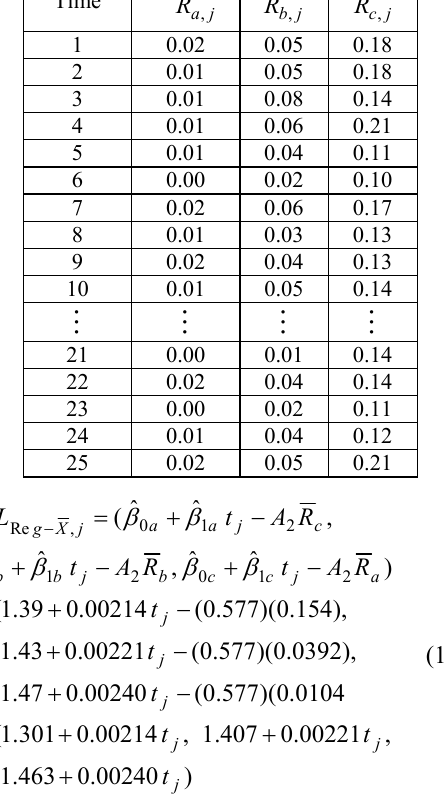
Table 4. Fuzzy ranges ),,( ,,, jcjbja RRR for each sample for the inner diameters of natural gas